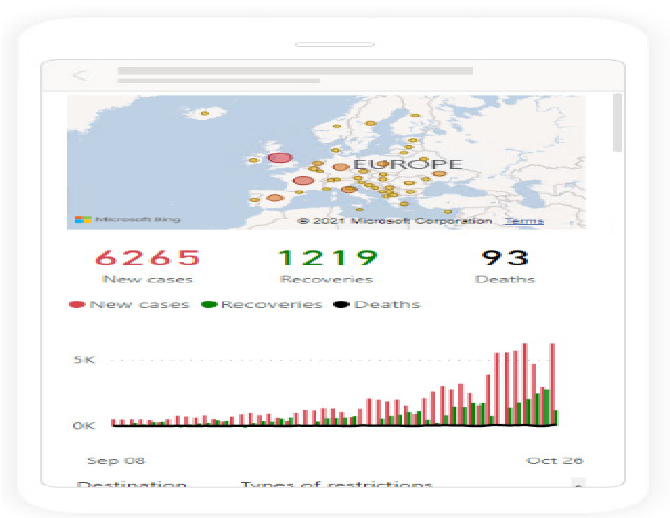
Figure 5. Relationship model of tables in Power BI in the presented example. Source: Authors own elaboration.